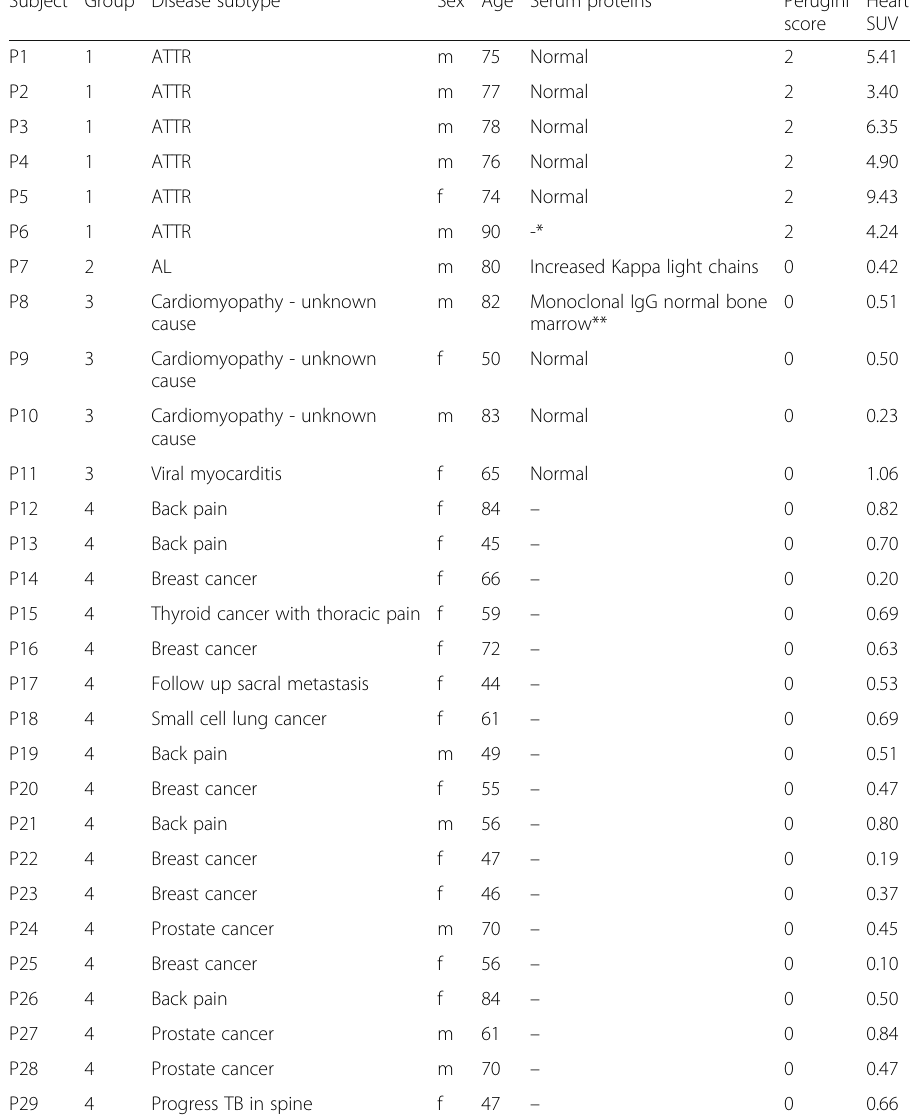
Table 1 Characteristics of the patients studied subdivided according to final diagnosis (*found to have disseminated malignancy, prognosis considered too poor for further cardiac investigation, **abdominal fat pad biopsy negative for amyloid, haematological diagnosis monoclonal gammopathy of undetermined